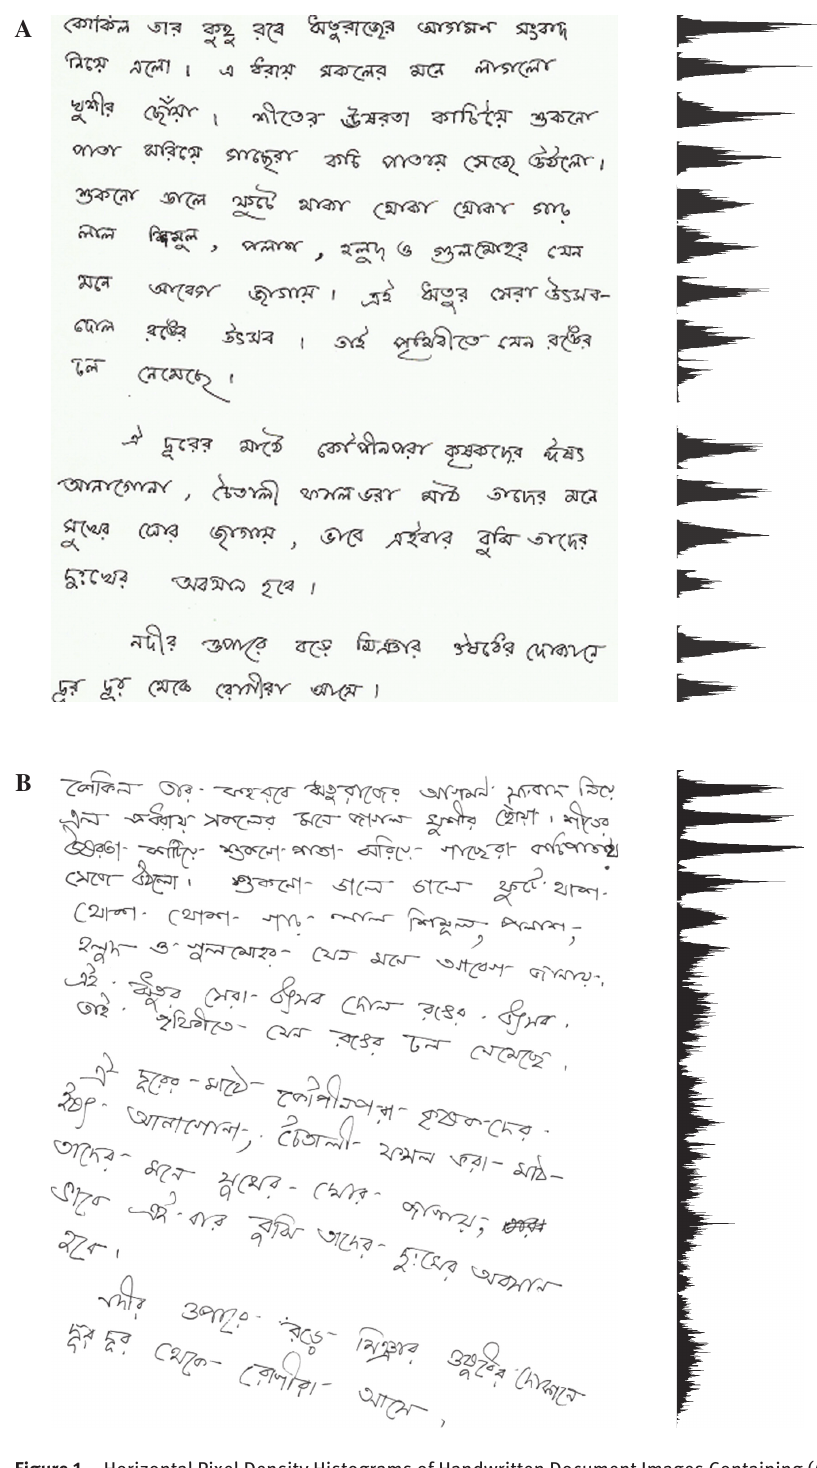
Figure 1. Horizontal Pixel Density Histograms of Handwritten Document Images Containing (A) Unskewed and (B) Multi-Ori- ented Text